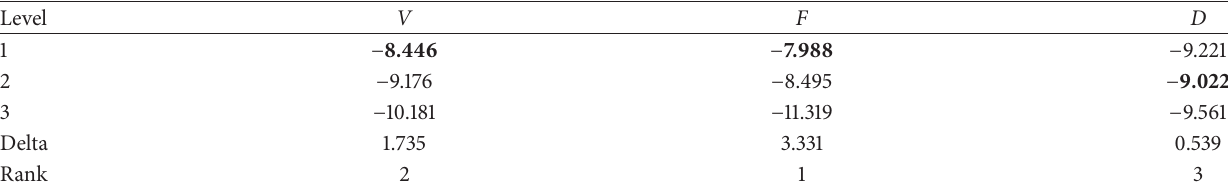
Table 12: Taguchi analysis: Ra versus V , F , and D for Al6061/12 wt.% Al 2 O 3 /6wt.% MoS 2